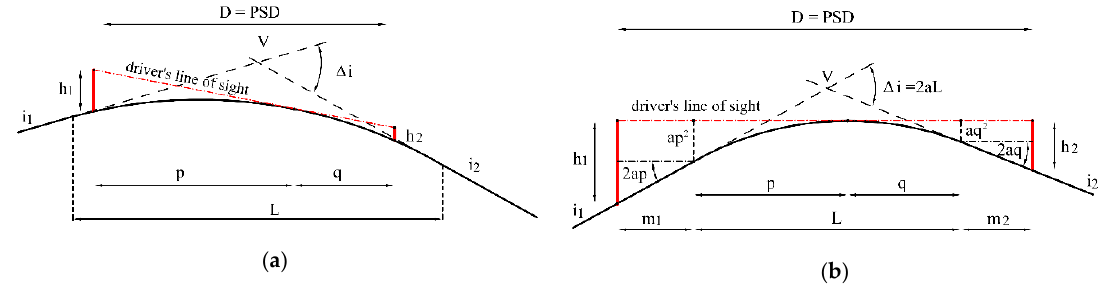
Figure 4. Crest curve radius derivation (case ( a ): D < L; case ( b ): D > L).